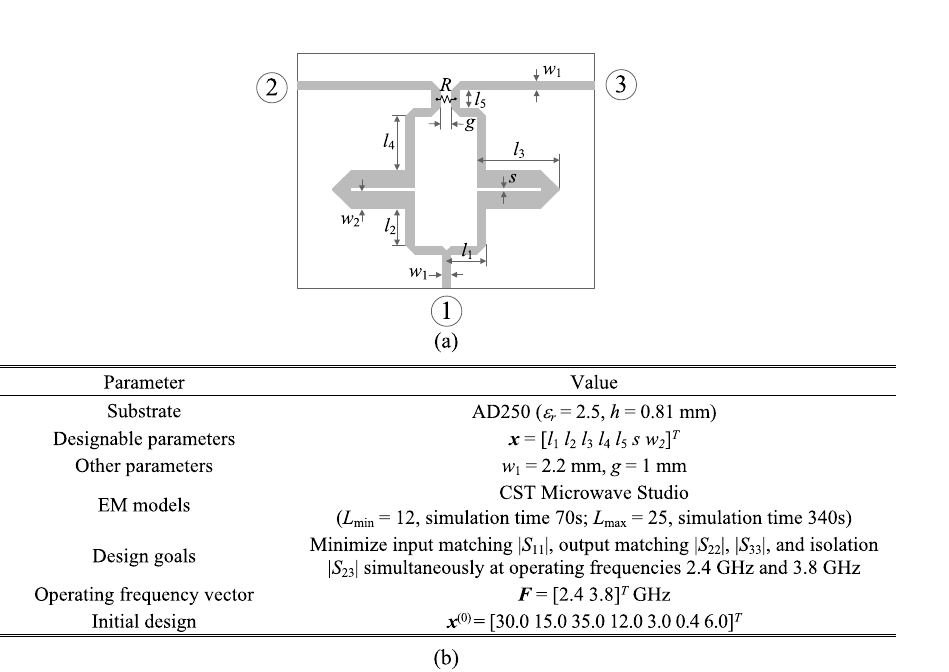
Figure 12. Dual-band power divider (Circuit III): ( a ) geometry 83 ; ( b ) main parameters and design